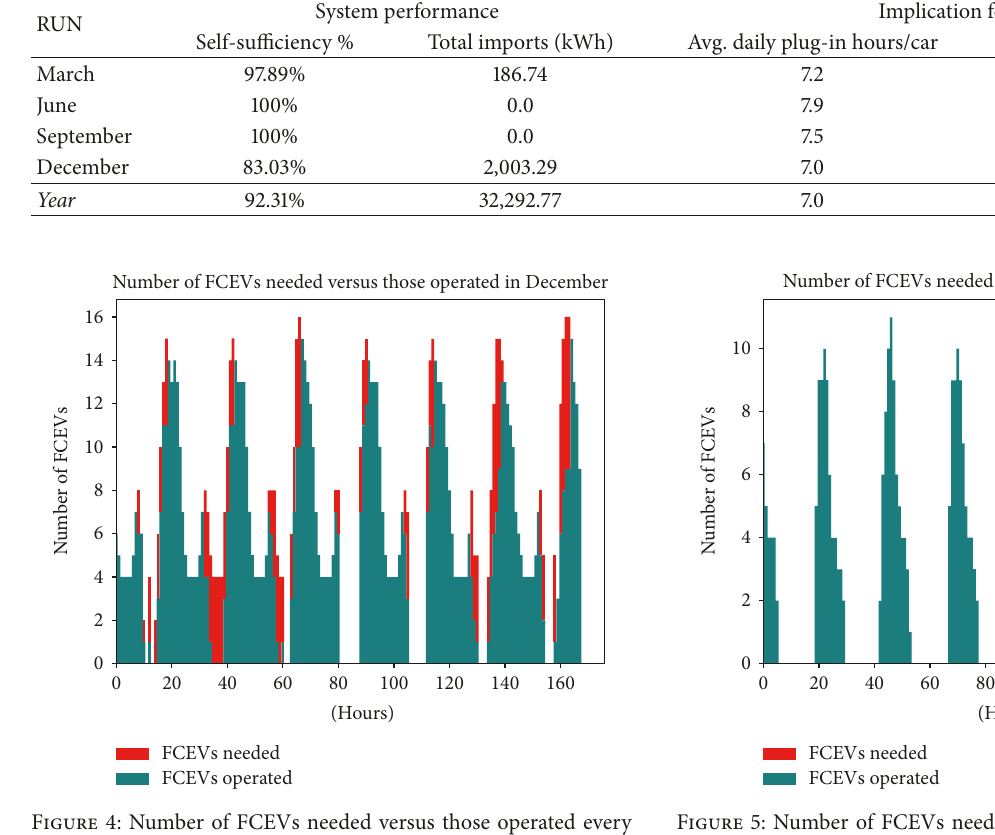
Figure 5: Number of FCEVs needed versus those operated every hour, in a week in